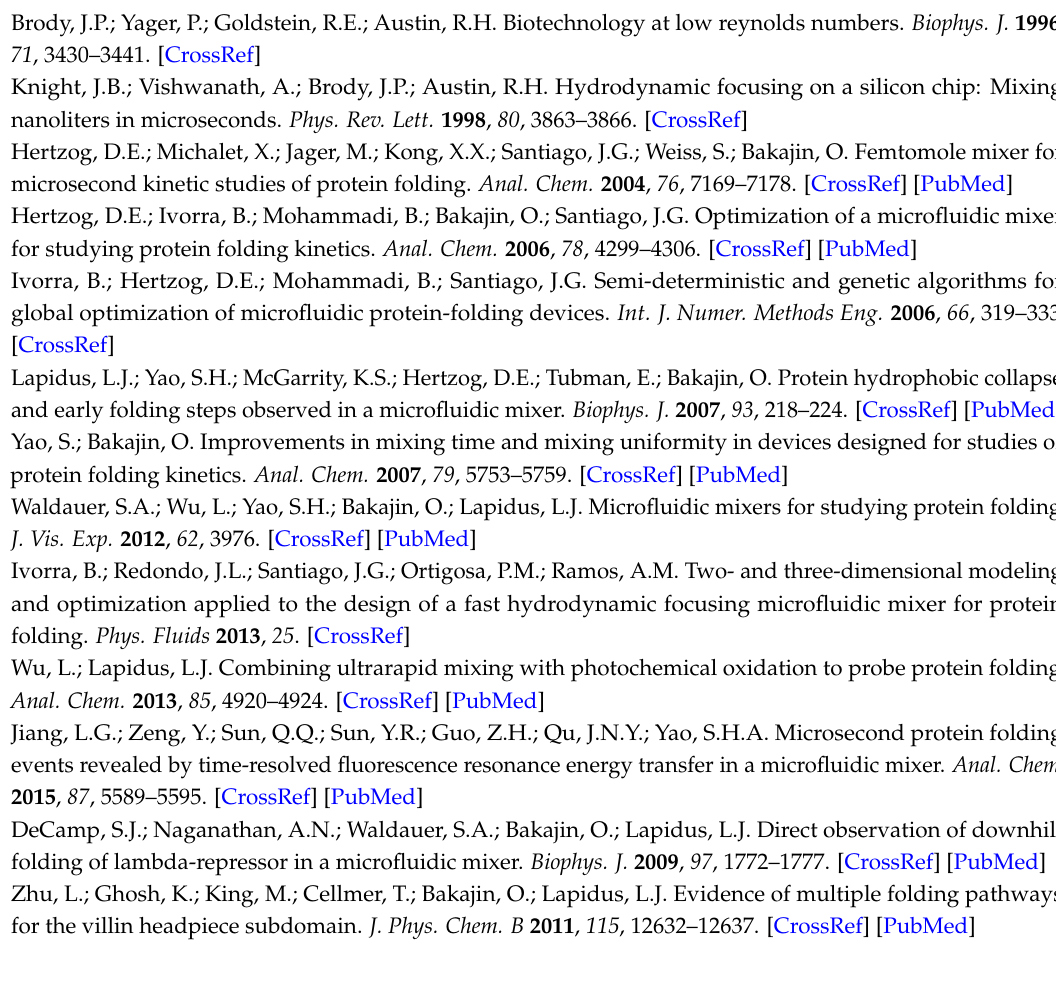
Figure S1: SEM image of KMPR 1010 layer after developing on the fused silica, Figure S2: SEM image of etched fused silica channels after removing KMPR1010, Table S1: Fabrication process for KMPR1010, Figure S3: the complete image of the structure of the ultrarapid